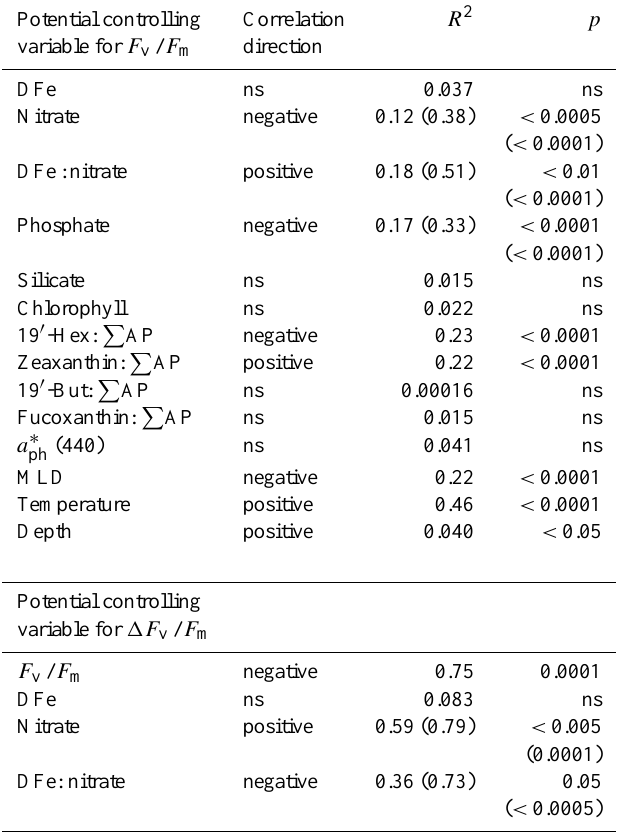
Table 1. Simple linear regression statistics for potential controls on F v / F m (0–50m) and 1F v / F m